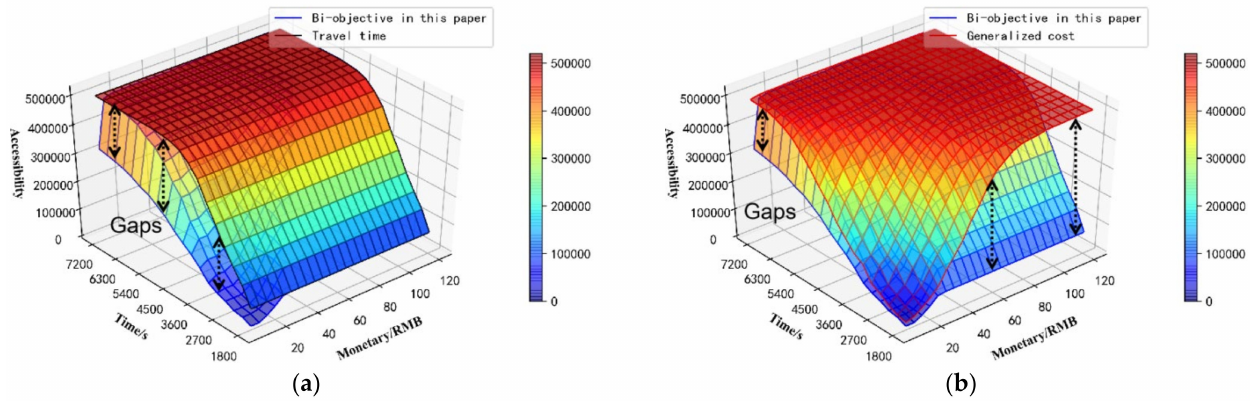
Figure 13. Comparison of different methods: ( a ) the travel time method, and ( b ) the generalized cost method.